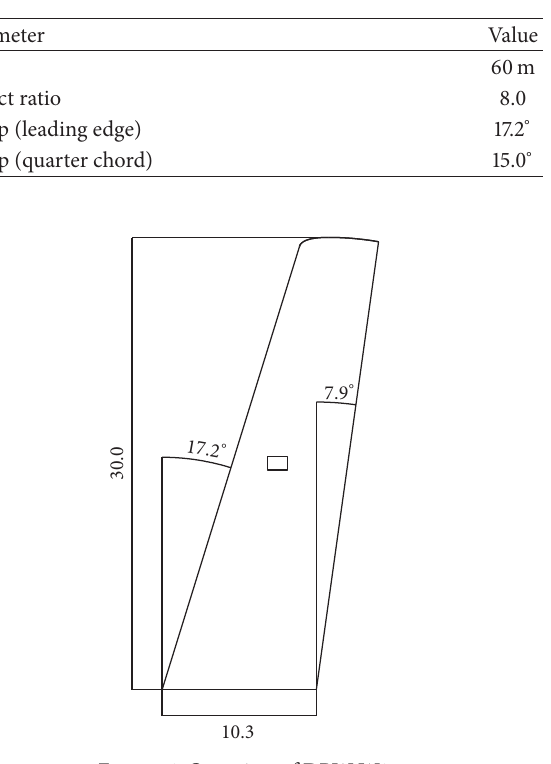
Figure 1: Overview of DPW-W1.